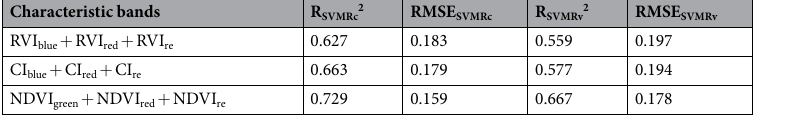
Building and testing of the SVMR estimation model. The SVMR model 1, 2 and 3 built using the chemical method, laboratory-measured chlorophyll content of 39 samples as dependent variables, and the vegetation indices series 1 (RVI blue , RVI red and RVI re ), series 2 (CI blue , CI red and CI re ) and series 3 (NDVI green , NDVI red and NDVI re ) as independent variables, respectively. The DPS statistical software was used to build the SVMR model. The model parameters were determined through parameter optimization, model regression and verification, and repeated analysis and comparison. The details are shown in Table 7. As shown in Table 8, the determinant coefficient of model 1 (R SVMR1c 2 ) was 0.627, and the root mean square error (RMSE SVMR1c ) was 0.183. The determinant coefficient of model 2 (R SVMR2c2 ) was 0.663, and the root mean square error (RMSE SVMR3c ) was 0.159. The surface albedo and chlorophyll content of 13 samples were used to test the model. As shown in Table 8, the verification determinant coefficient of model 1 (R SVMR1v2 ) was 0.559, and the verification root mean square error (RMSE SVMR1v ) was 0.197. The verification determinant coefficient of model 2 (R SVMR2v2 ) was 0.577, and the verification root mean square error (RMSE SVMR2v ) was 0.194. The verification determinant coefficient of model 3 (R SVMR3v2 ) was 0.667, and the verification root mean square error (RMSE SVMR3v ) was 0.178. At the same time, the predicted values of the chlorophyll content of the canopy for the tested samples were compared 1:1 with the measured values (e.g., Fig. 6). The determination coefficient of building and testing the SVMR model 3 based on the vegetation indices series 3 (NDVI green , NDVI red and NDVI re ) was maximal, and its RMSE was minimal. This indicates that model 3 has better self-estimation and estimation abilities and can be used for the quantitative estimation of the apple canopy chlorophyll content. Optimization of two estimation models. Comparing the BPNN and the SVMR, in general, the SVMR can have better accuracy than that of the BPNN model because of its structure risk minimization (SRM) principle (whose aim is that of minimizing the upper bound of the generalization error rather than the training error), SVMR has fewer free parameters to optimize and it can eliminate over-fitting training and local minima 31 . The results supported the opinion above. In the BPNN estimation models, the R 2 of building and testing for model 3 based on series 3 (NDVI green , NDVI red and NDVI re ) were maximal, and were 0.674 and 0.601, respectively.